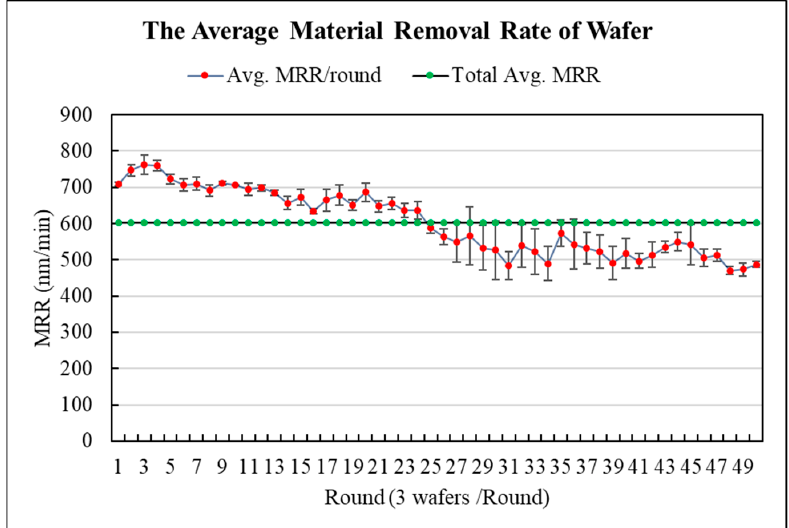
Figure 12. Average MRR of CuB wafer of 50 rounds of test.